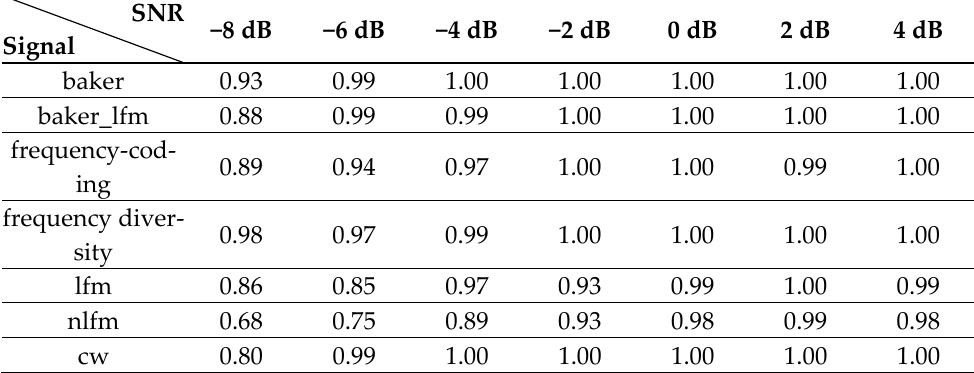
Table A2. Recognition results of one-dimensional DRSN under Laplacian noise.